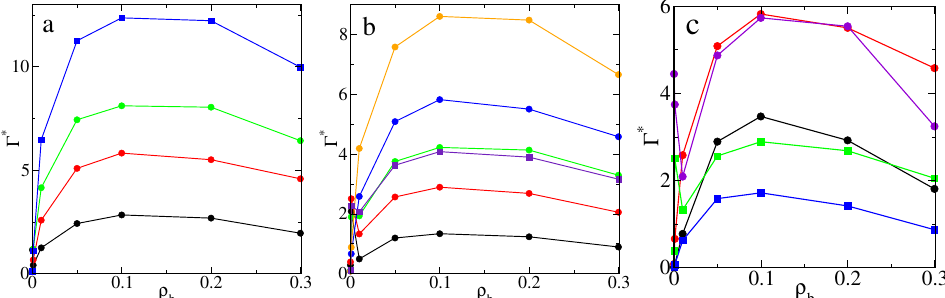
Figure 1. Excess adsorption isotherms for the model M1 and ε Ps = 1.5 ε : ( a ) the hairy particle, σ c = 4 σ , M = 20 (circles): f = 10 (black), 20 (red), 30 (green), and M = 30, f = 30 (blue squares), ( b ) the hairy particle, σ c = 4 σ , f = 20 (circles): M = 5 (black), 10 (red), 15 (green), 20 (blue), 30 (yellow), and f = 30, M = 10 (violet squares), ( c ) M = 20, ρ gr = 0.398 (circles): the flat substrate, f = 20 (black), the hairy particle, σ c = 4 σ , f = 20 (red), the hairy particle, σ c = 2 σ , f = 5 (violet), and f = 20, M = 10 (squares): the flat substrate (blue), the hairy particle, σ c = 4 σ (green). Symbols correspond to the simulation points. Lines serve as a guide to the